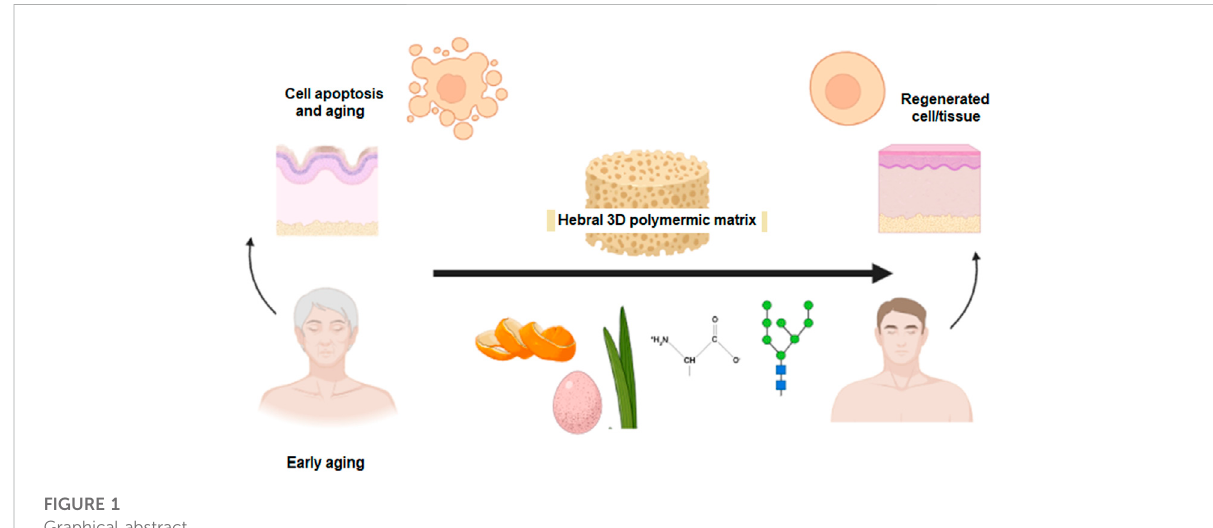
FIGURE 1 Graphical